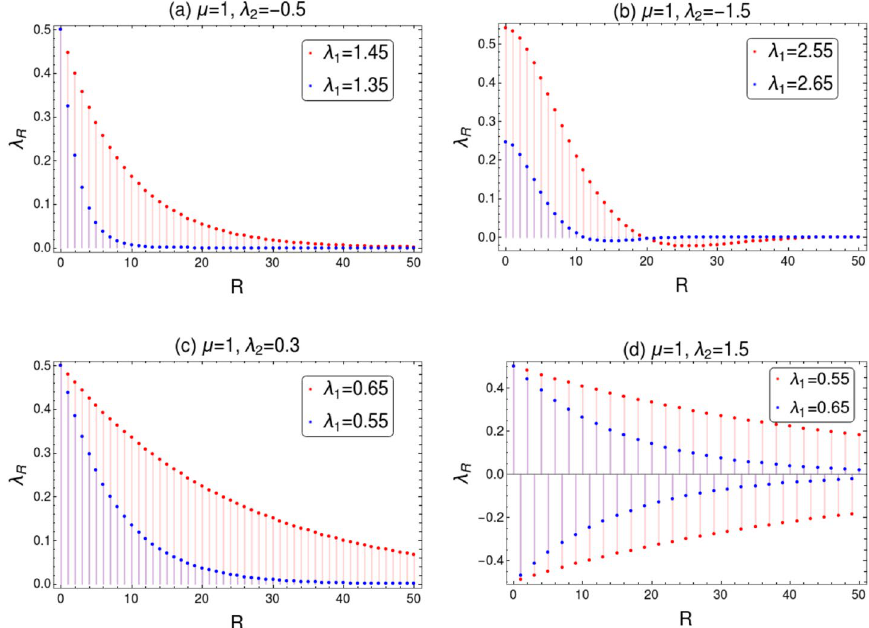
Figure 12. Behavior of correlation function (cid:31) R near quantum critical lines. ( a ) (cid:31) R is plotted near the critical line (cid:31) (cid:31) µ 2 1 for the transition between = − ( b ) (cid:31) R is plotted near the critical line (cid:31) 2 2.5 . ( c ) (cid:31) R is plotted near the critical line (cid:31) 2 critical value of (cid:31) 1 =